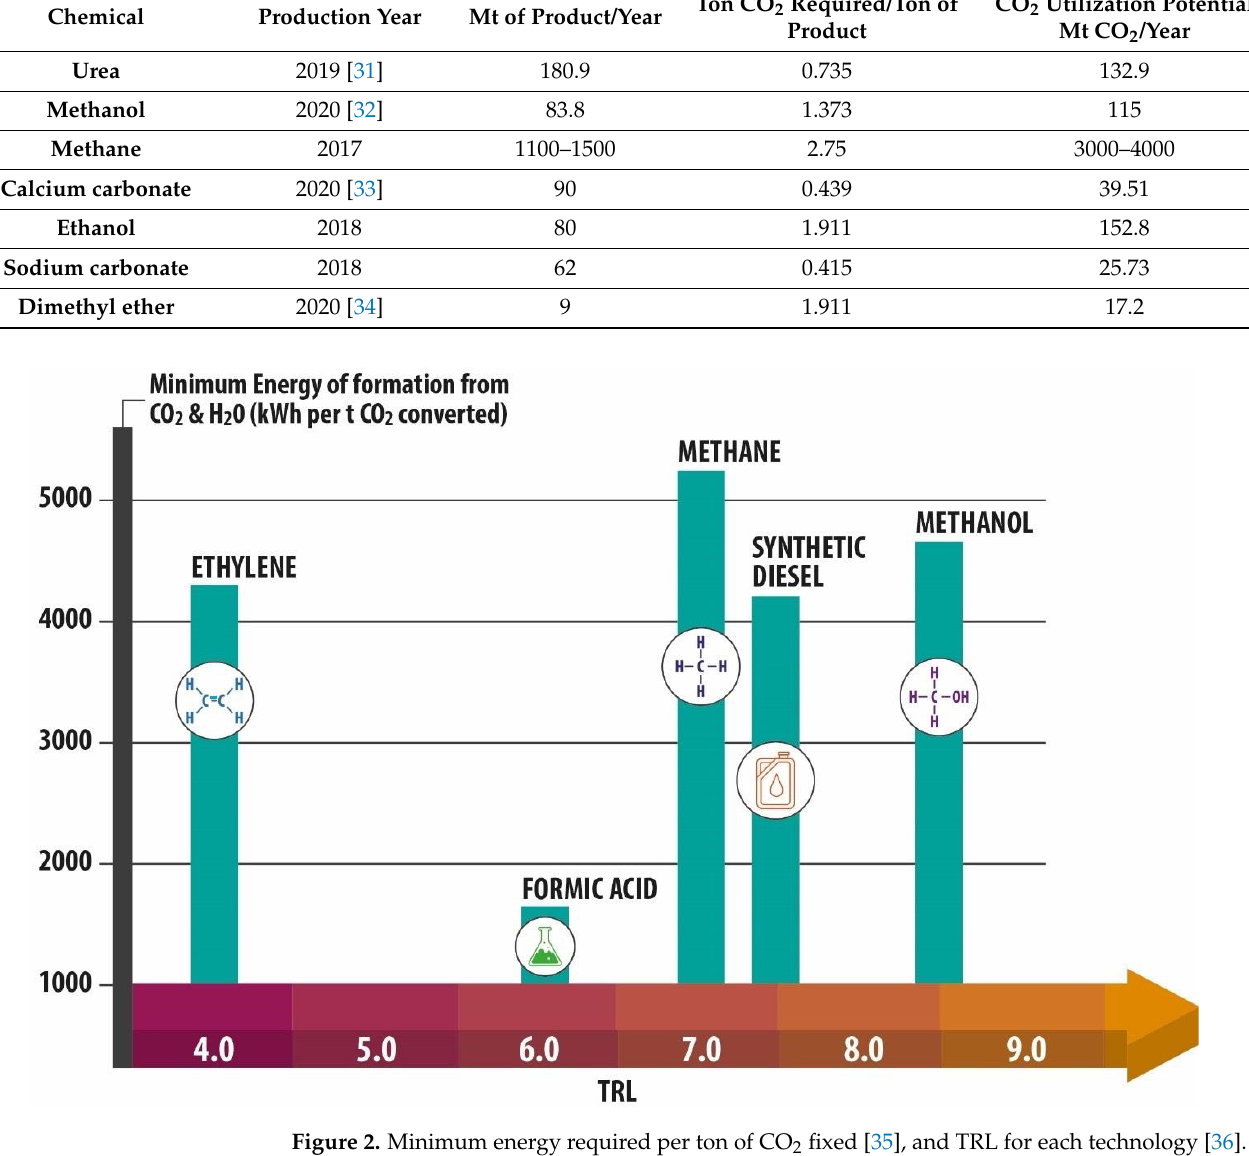
Table 1. CO 2 utilization potential for different reuse pathways [30]. Table 1. C O 2 utilization potential for different reuse pathways [30].